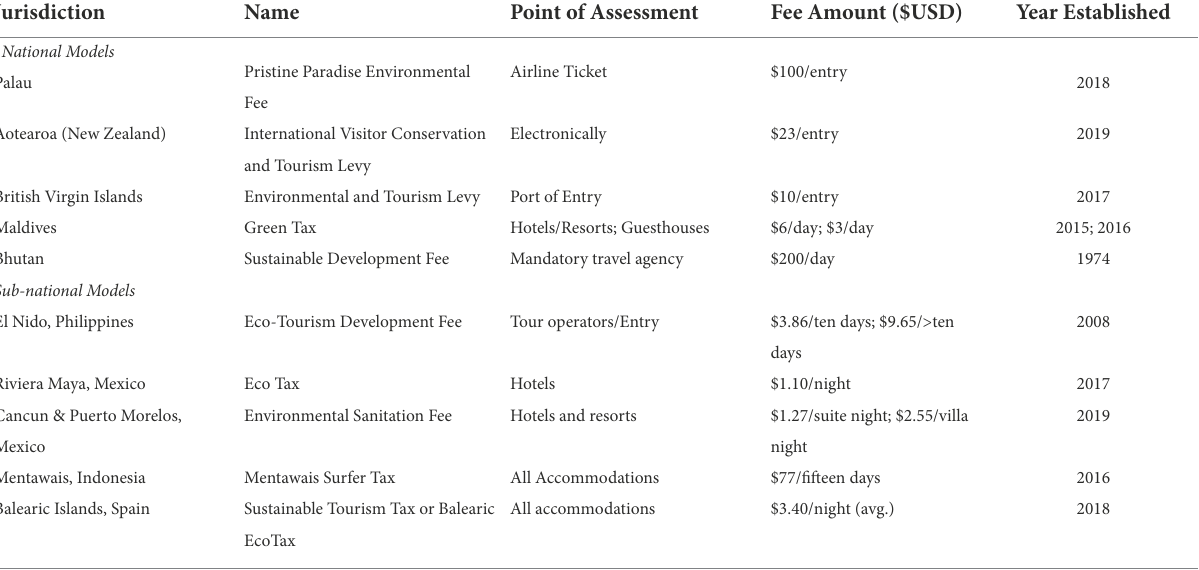
TABLE 1 Inventory of visitor green fee programs